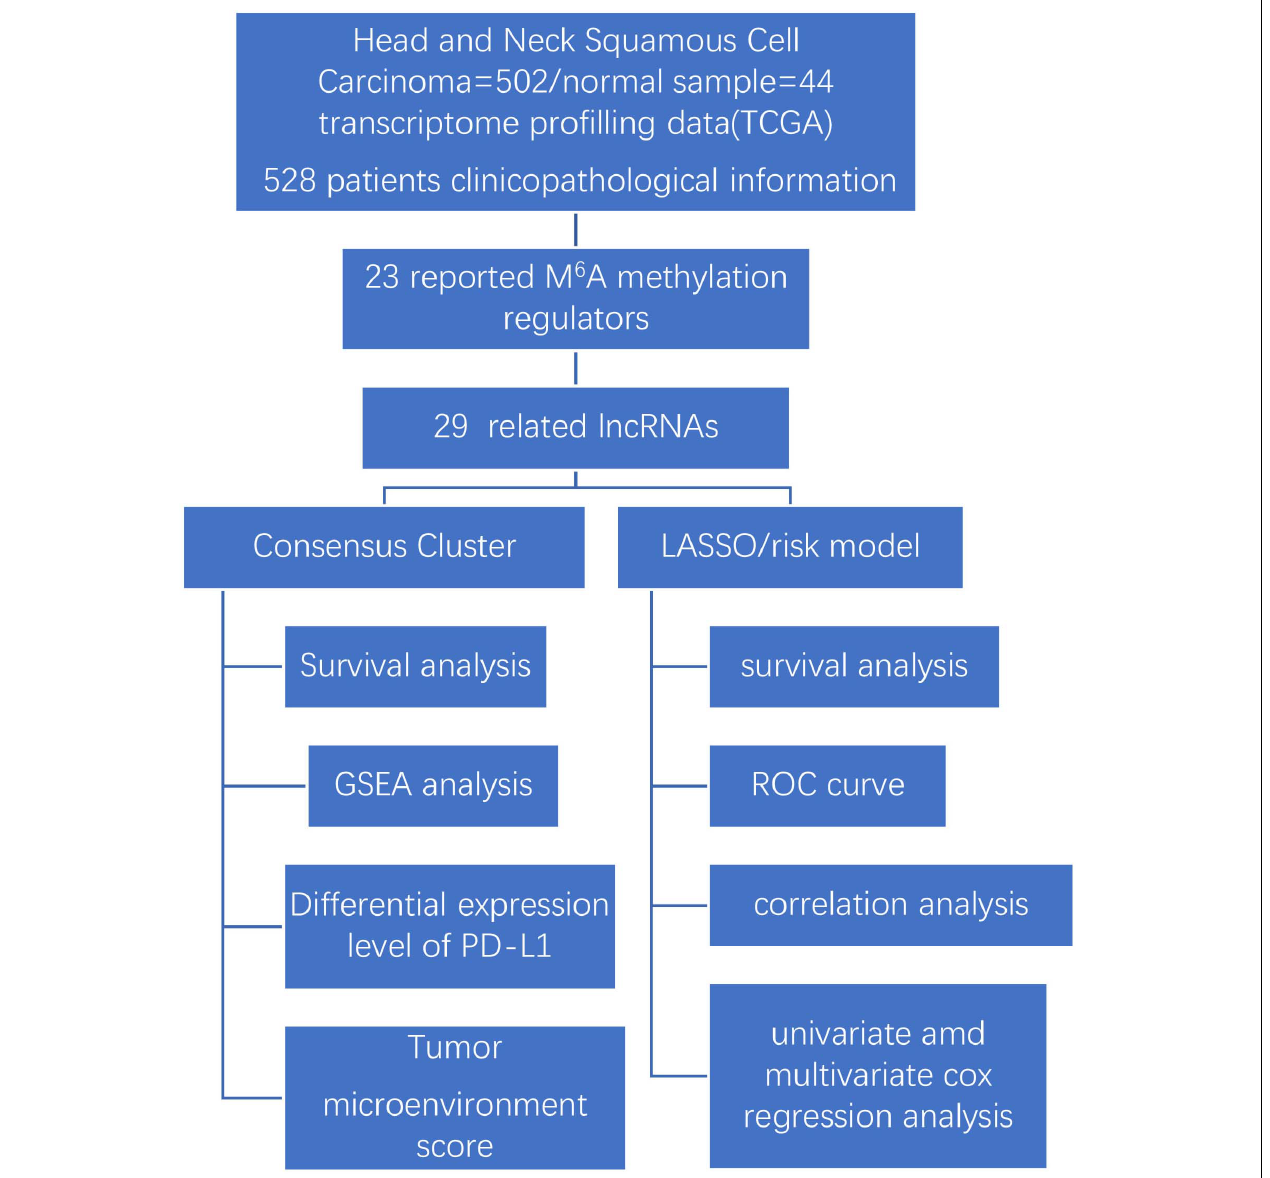
FIGURE 1 | Workflow chart of data generation and